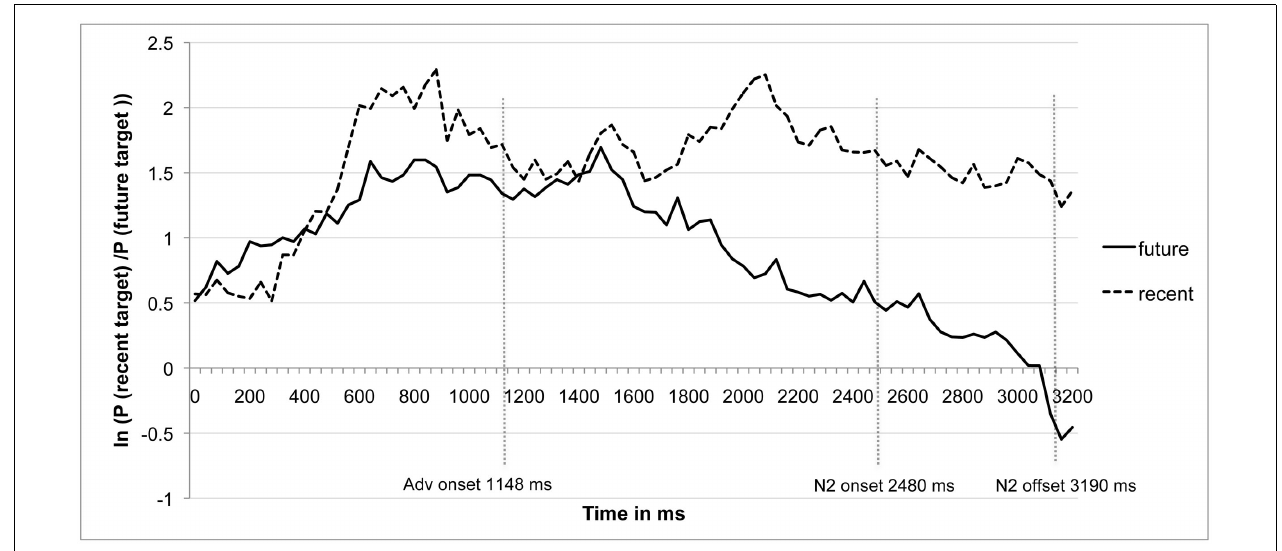
FIGURE 3 | Mean log gaze probability ratios ln (P(recent target)/P(future target)) as a function of condition fromVerb Onset for Experiment 2.